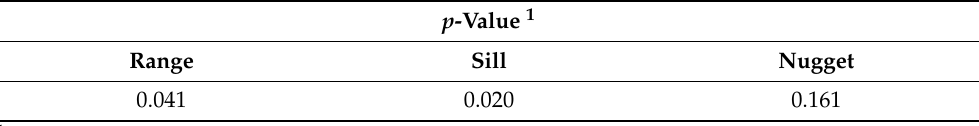
Table 3. Paired difference test (Wilcoxon signed-rank test) of variogram parameters between the surface and subsurface layer. p -Value 1 Range Sill